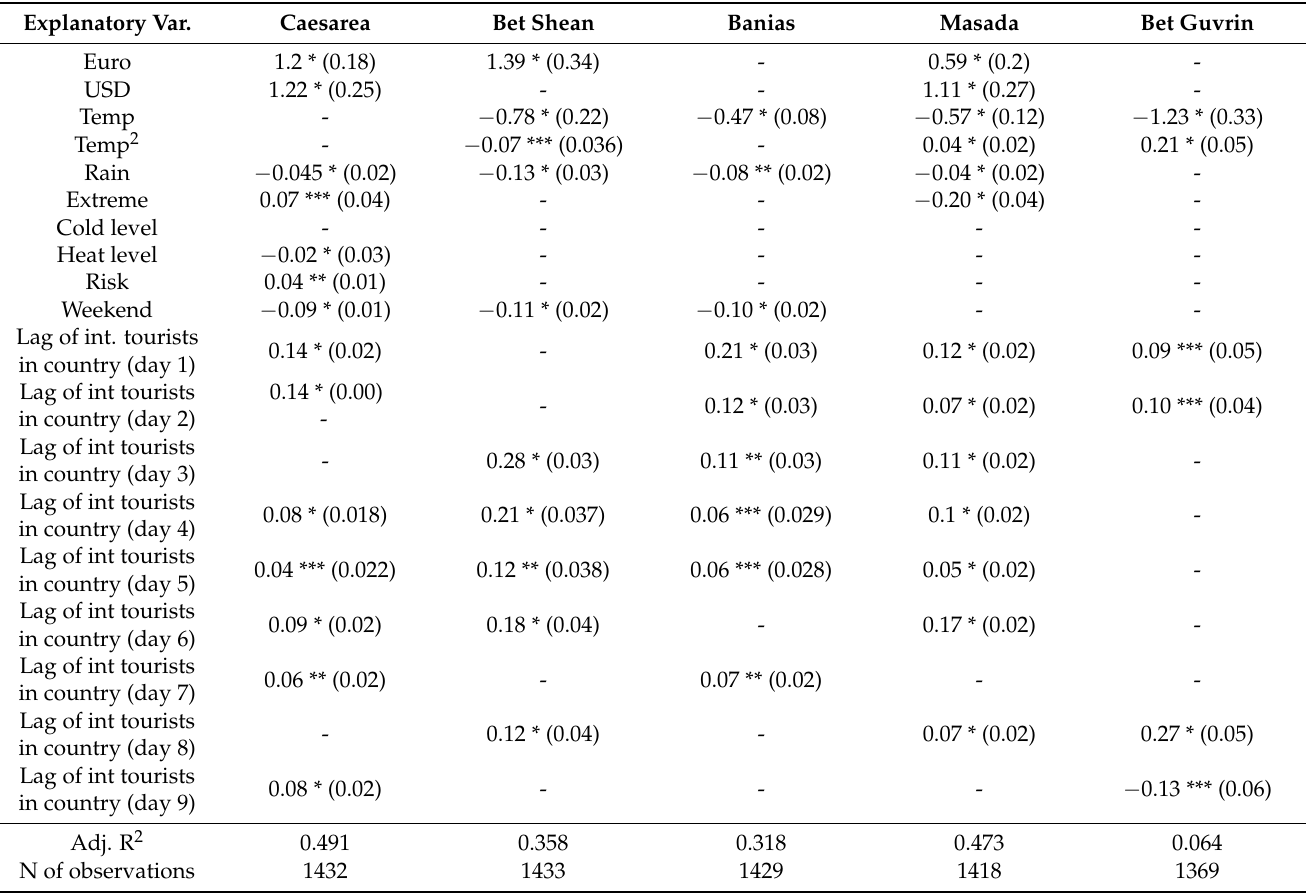
Table 2. Regression results for the number of international tourists visiting each national park (dependent variable in natural log